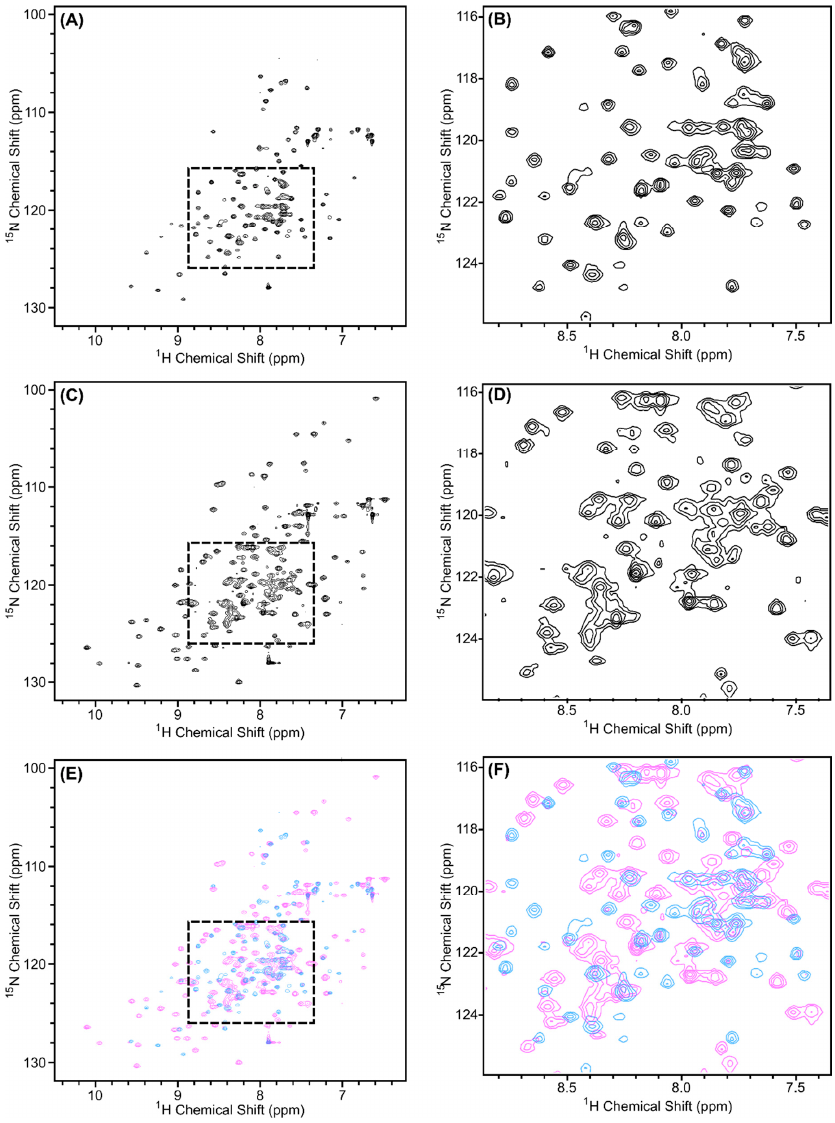
Figure 10. 1 H, 15 N-HSQC spectra of ( A , B ) 15 N-Scc4 and ( C , D ) Scc4 in the 15 N-Scc4:His 6 -Scc1 renatured complex. ( E , F )Overlayofthe 1 H, 15 N-HSQCspectraof 15 N-Scc4(blue)andScc4inthe 15 N-Scc4:His 6 -Scc1 renatured complex (pink). ( B , D , F ) Expanded regions from dashed boxes in ( A , C , E ),